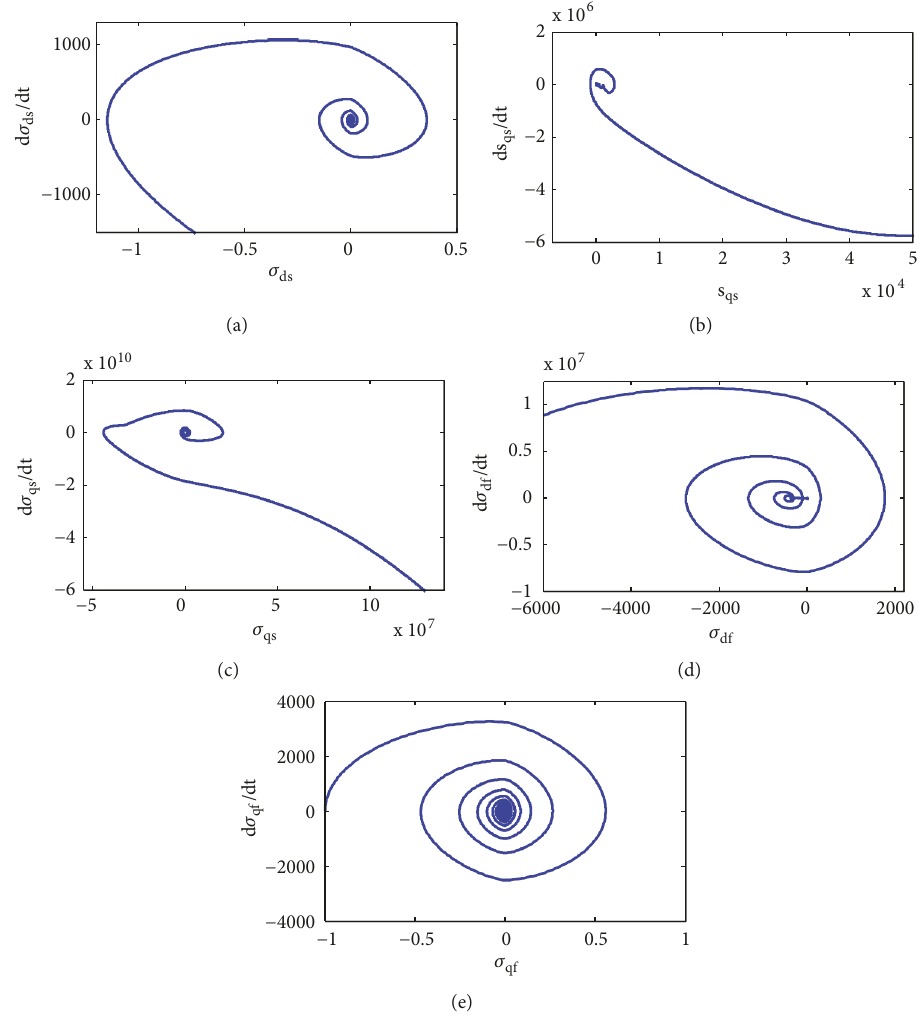
Figure 11: Phase portraits of the sliding variables.